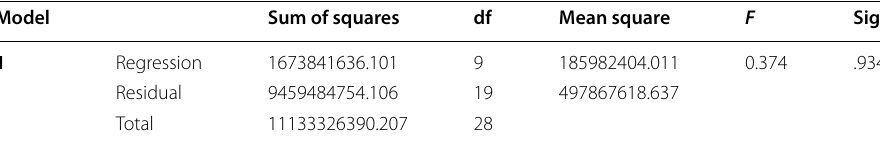
Table 7 Analysis of variance (ANOVA) for factor 1 variables Model Sum of squares df Mean square F Sig.